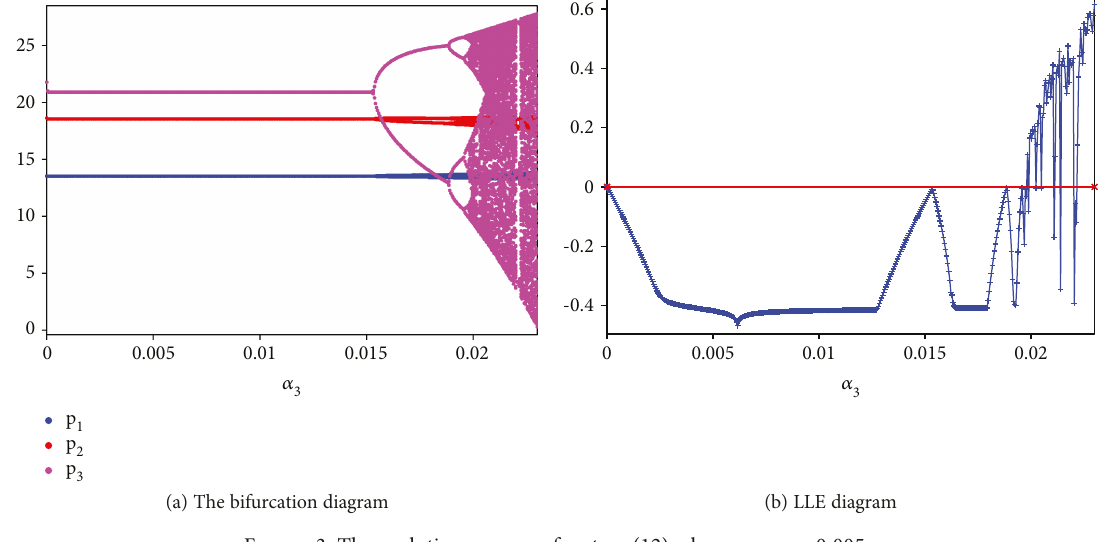
Figure 3: The evolution process of system (12) when α